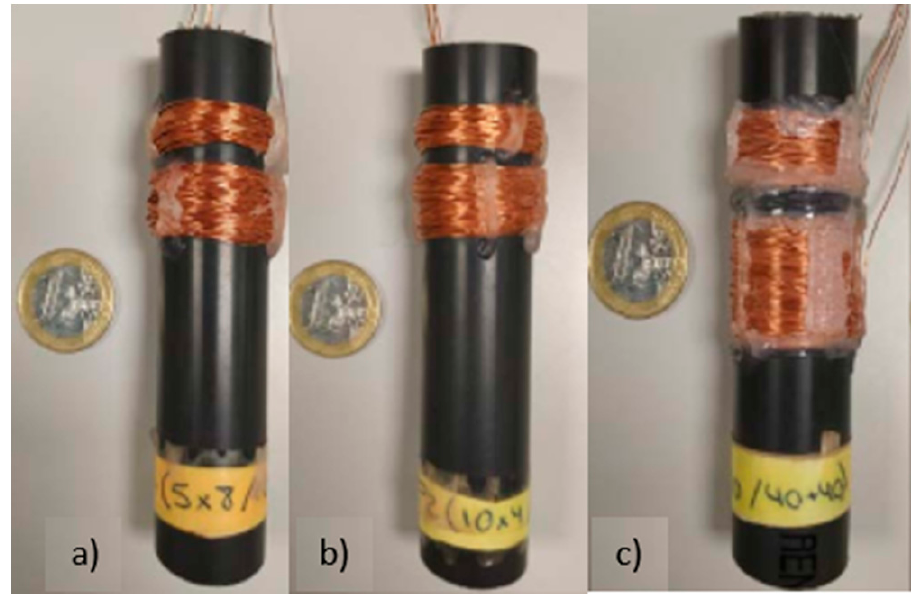
Figure 2. Representation of used prototype: ( a ) prototype 1 (P1)-40PC and 80IC (8 layers); ( b ) P2-40PC and 80IC (4 layers); ( c ) P3-40PC and 80IC (2 layers). Table 1. Technical specification of the prototypes, with different number of layers.